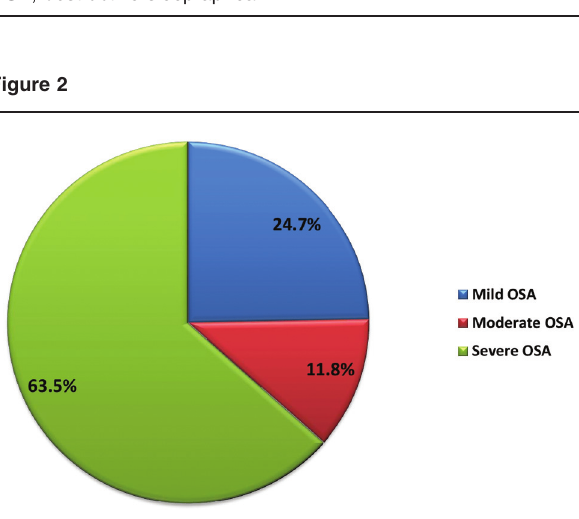
OSA severity in OSA patients with IBS.IBS, irritable bowel syndrome; OSA, obstructive sleep